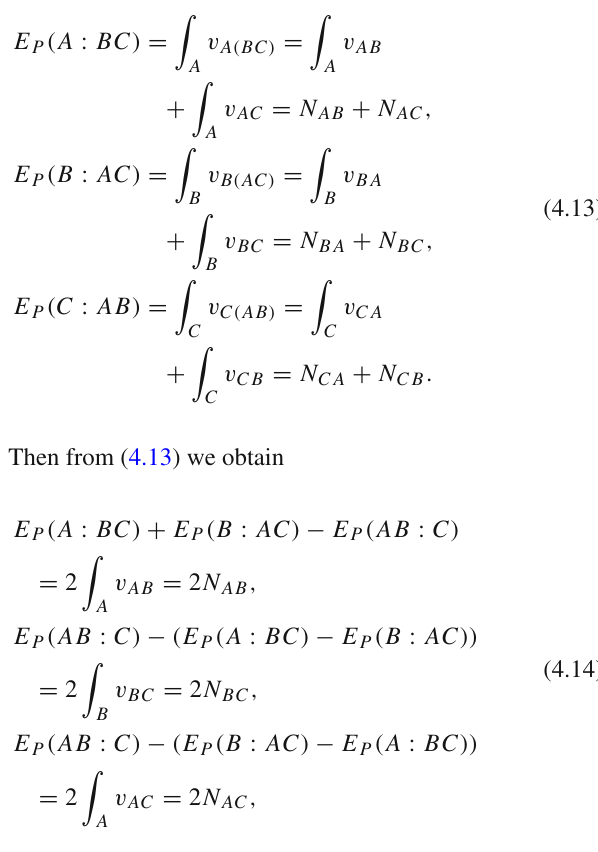
Fig. 3 The max thread configuration for tripartite case. Threads are unoriented and can intersect with others. The number of threads con- necting to each single region reaches its maximum